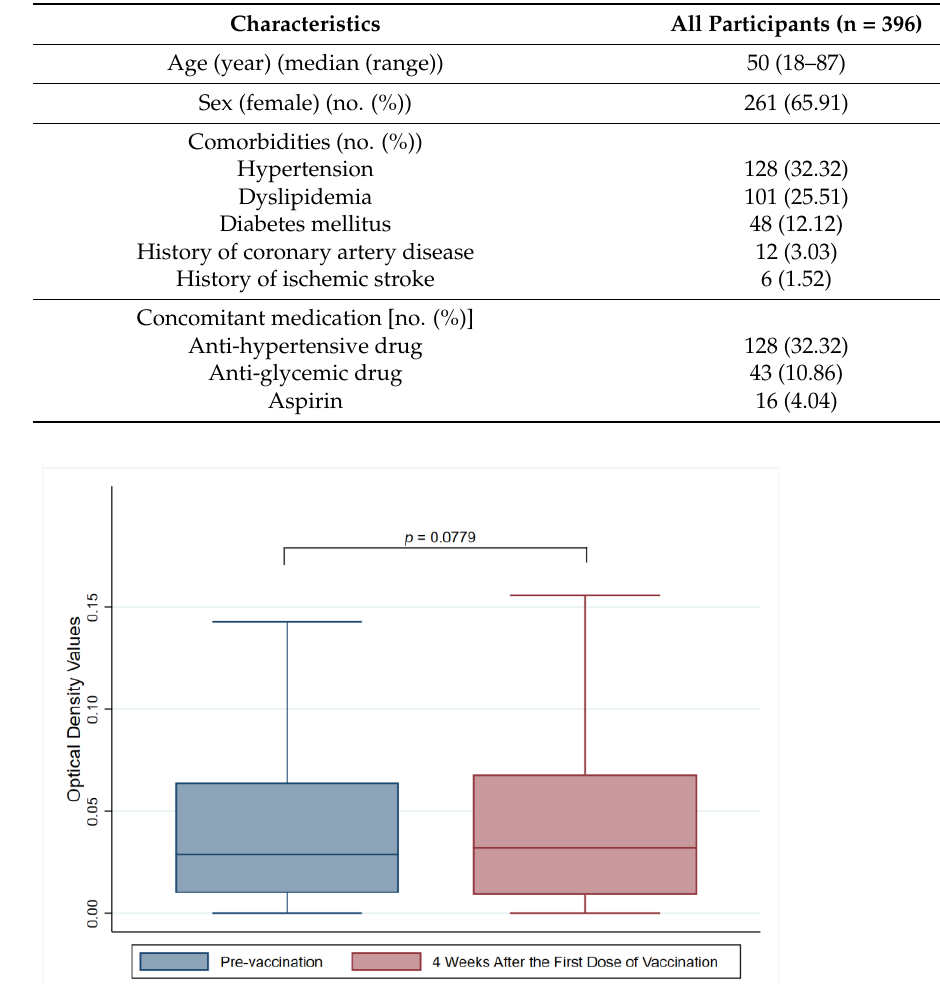
Figure 2. Median optical density values of anti-PF4 antibodies measuring pre-vaccination and four weeks after the first vaccination dose.